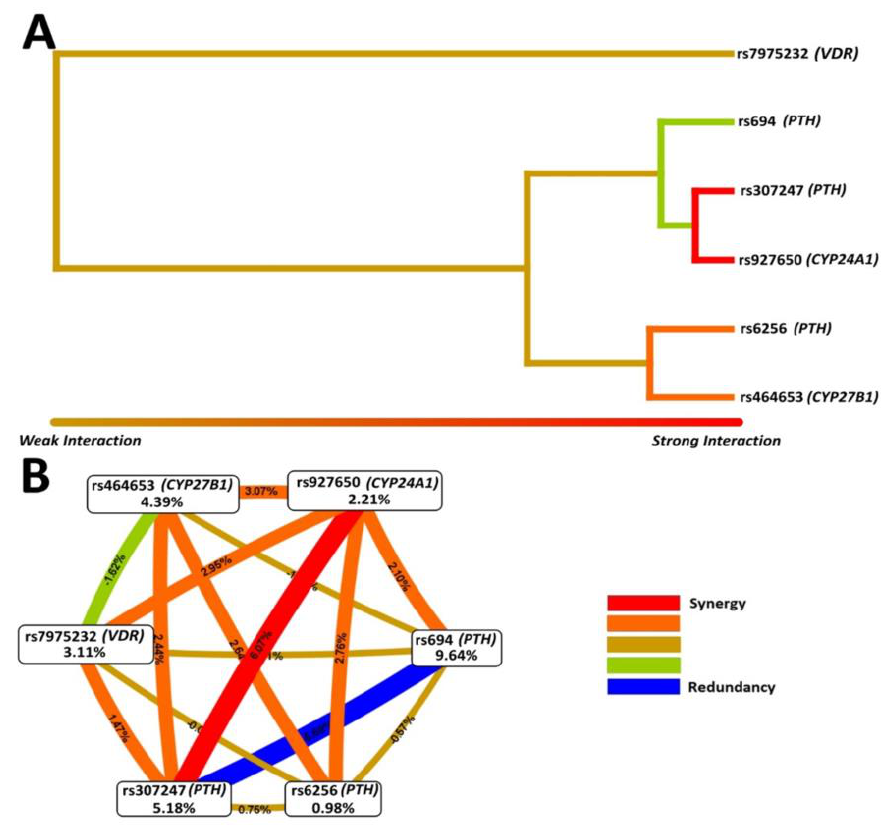
Figure 3. Interaction analysis for the studied SNPs by MDR. ( A ) Interaction dendrogram. Dendro- gram shows keys connecting the SNPs. Strongly interacting SNPs are connected by keys farther to the right, whereas the weakly interacting SNPs are connected by keys farther to the left. ( B ) Interaction entropy graph. Each SNP are represented by a node and percentages inside the nodes are their entropy values. The percentages between the nodes indicate the entropy values resulting from the combination between SNPs.